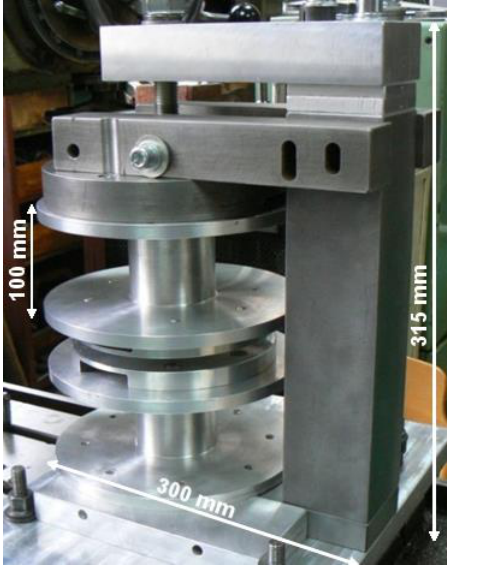
Figure 6. Scheme of measuring the real value of magnetic flux density with the LZ-614H probe in mm. The next stage of the study was a design of experiment for the ranges of machining parameters selected on the basis of the literature [24]. We determined three parameters with the greatest expected machining results.